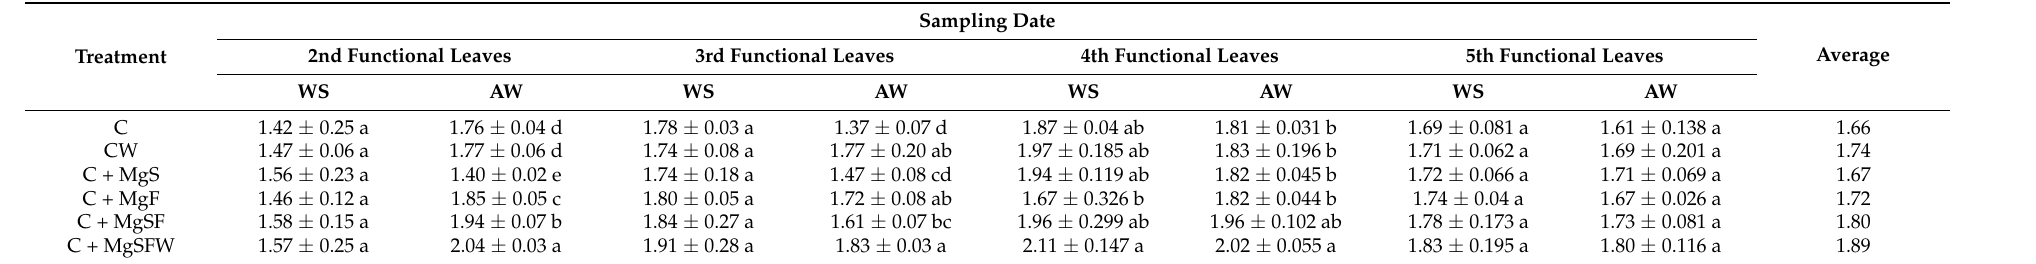
Different letters in the same column means significant differences between different treatments at p < 0.05. Table 3. The total chlorophyll contents of functional leaves in different treatments of Mg fertilizers application (mg g − 1